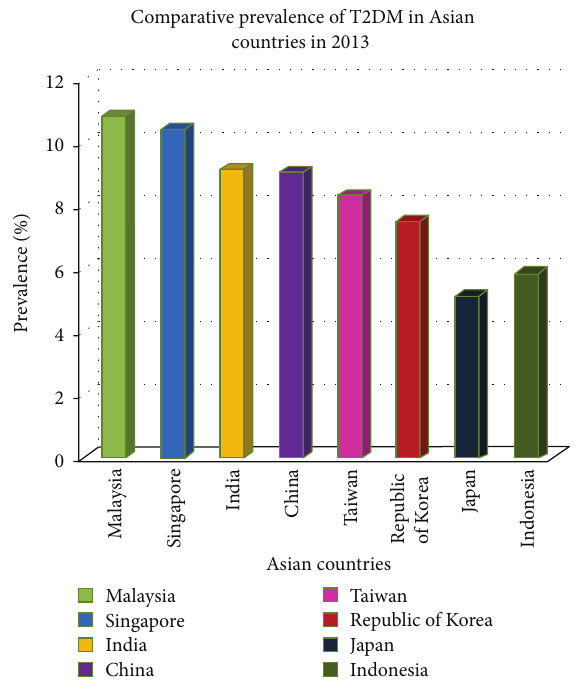
Figure 2: Comparative prevalence of Type 2 diabetes melli- tus in Asian countries in 2013 (data source: http://www.idf.org/